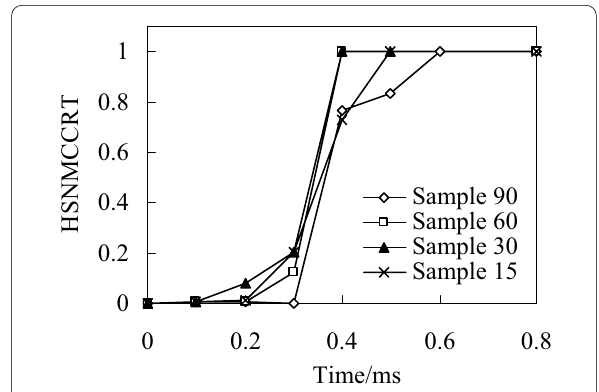
Fig. 8 Relationships of matrix compression failure and impact time history